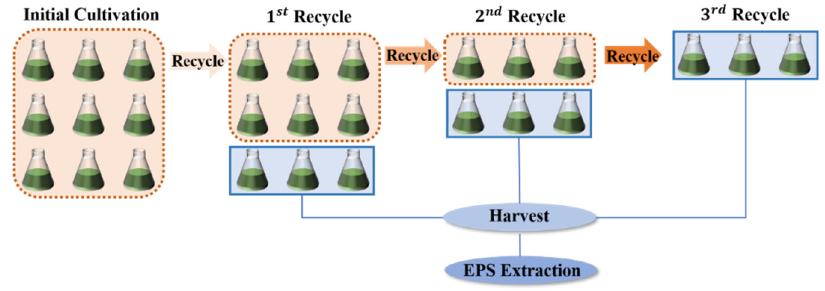
Figure 1. Experimental design of the medium recycle. Table 1. Experimental set-up of the cultures using nitrate (NaNO 3 ) and ammonium (NH 4 Cl) as nitrogen source.